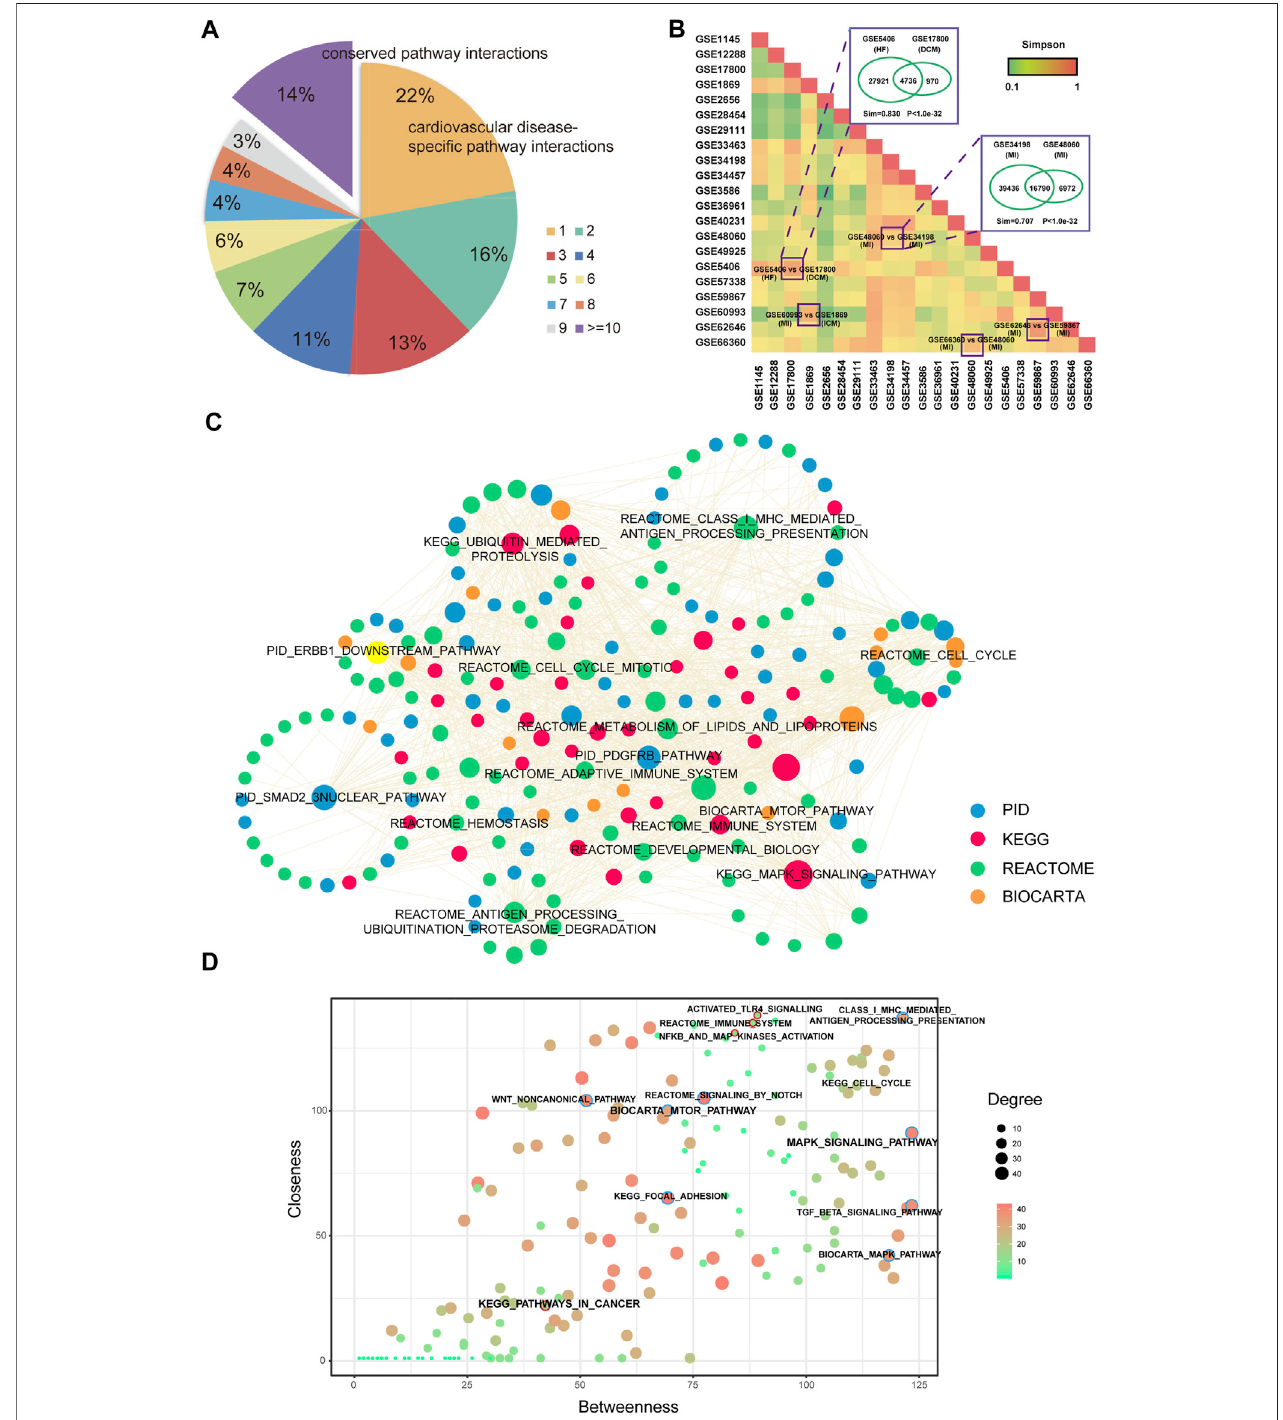
FIGURE 3 | Comparison analysis of pathway crosstalk across multi-CVDs. (A) Pie chart of distributions of pathway crosstalk in multi-CVDs. (B) Heatmap of the Simpson index represents the similarity between each pair of pathway crosstalk networks. (C) A common core pathway crosstalk network. (D) A pathway – pathway crosstalk of common core pathway crosstalk network.